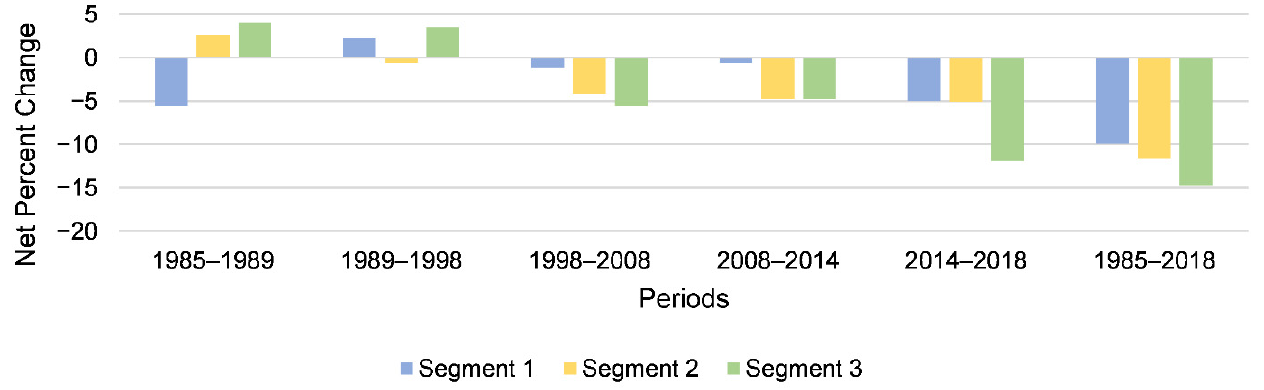
Figure 3. Net percent change by segment. Note: the change percentages are indicated with respect to the beginning of each analyzed year and the last period indicates the overall change for 1989– 2018.